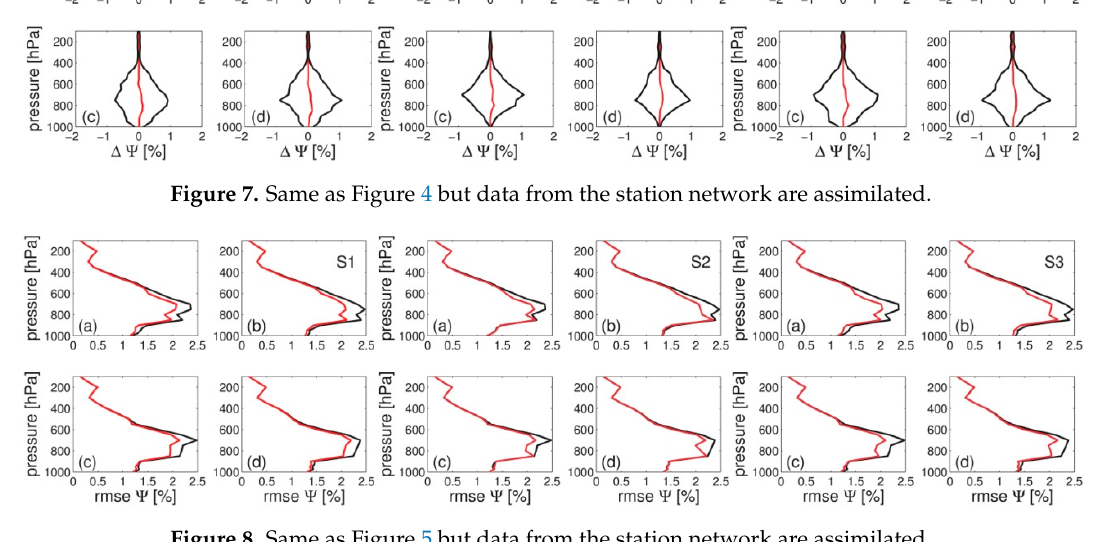
Figure 8. Same as Figure 5 but data from the station network are assimilated.